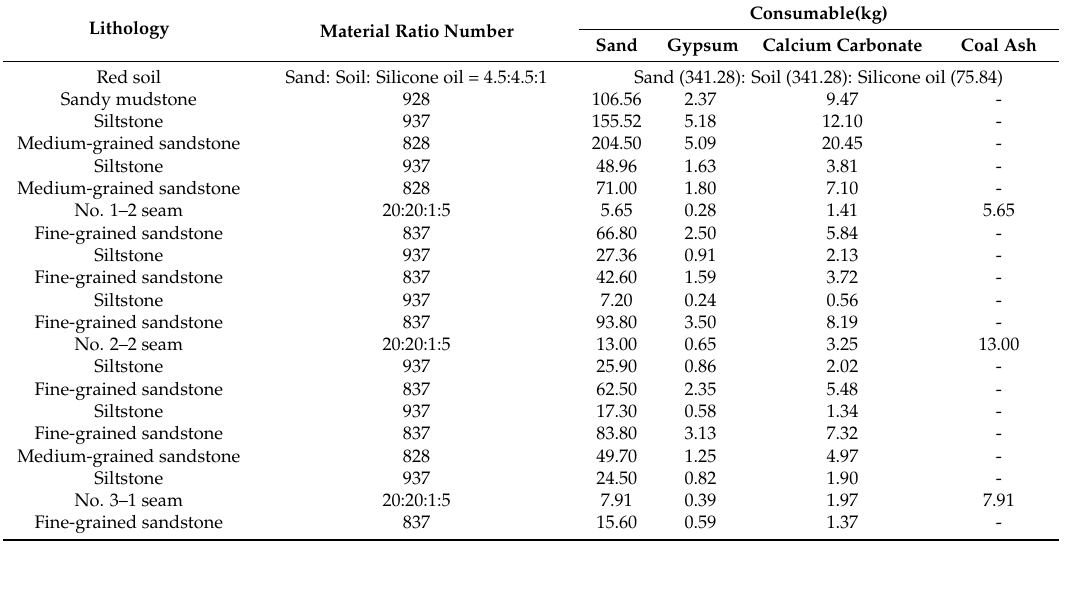
Figure 4. Experiment model design: ( a ) physical simulation model; ( b ) sketch model. Table 2. Material ratio of model.